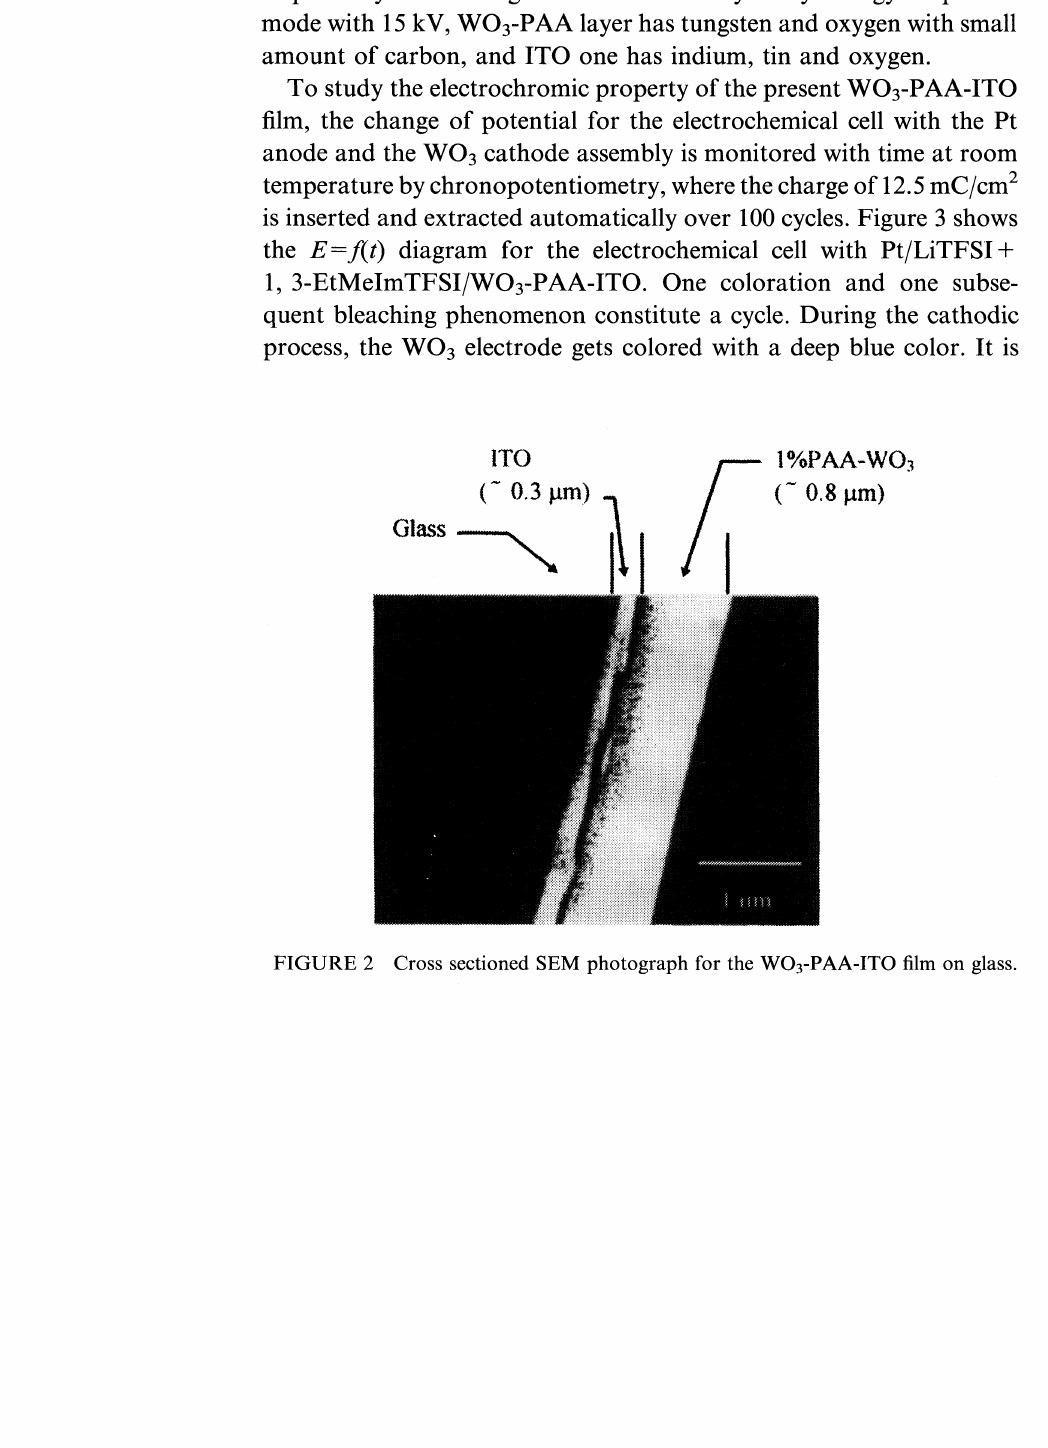
FIGURE 2 Cross sectioned SEM photograph for the WO3-PAA-ITO film on